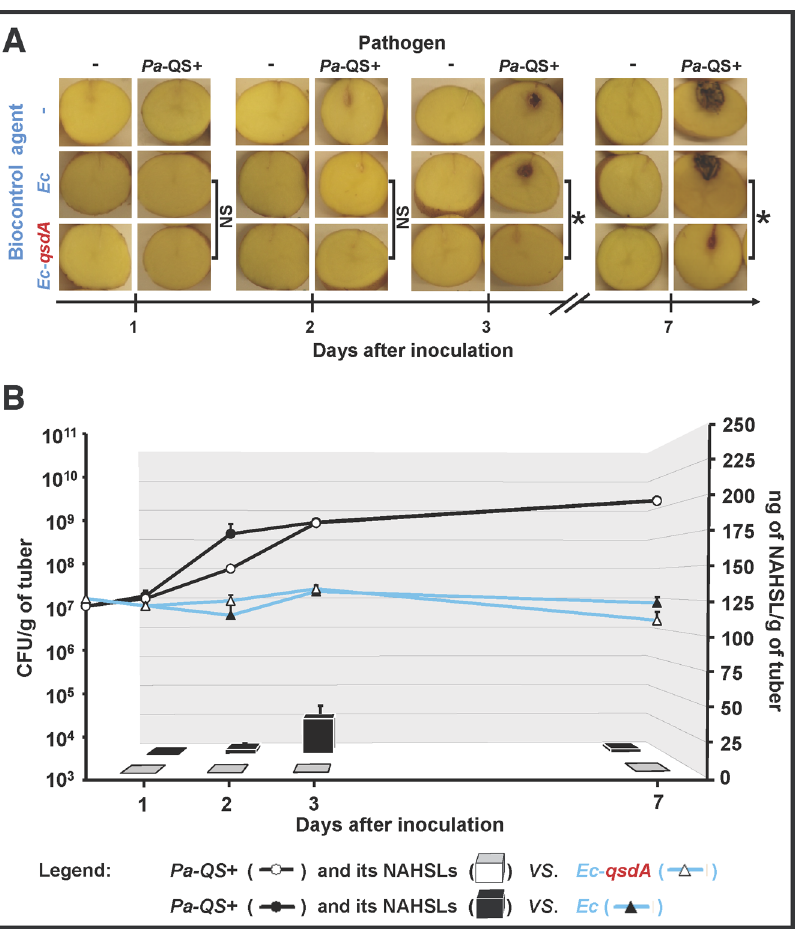
Figure 3. NAHSL-breakdown and biocontrol activity of the QsdA-expressing E.coli strain in potato tubers. (A) E. coli DH5 a (pUC19) ( Ec ) and E. coli DH5 a (pUC19- qsdA ) ( Ec-qsdA ) were compared for biocontrol activity against P. atrosepticum 6276 ( Pa -QS + ) 1, 2, 3 and 7 days after inoculation of potato tubers. For the controls, one or both strains were replaced in the inoculum with a 0.9% NaCl solution. Significant differences (Mann and Whitney test; a =0.05) in maceration symptoms between infected tubers inoculated with the Ec or the Ec-qsdA strains are indicated with an asterisk. (B) Population dynamics of P. atrosepticum and E. coli bacteria (CFU/g fresh weight of potato tubers; black and blue lines respectively), and NAHSL concentration (ng/g of potato tubers; black and white bars), were determined for each condition in potato tubers. For lines and bars, each value is the mean of three replicates with the standard deviation indicated. NS, non-significant; NAHSL, N -acyl homoserine lactone.